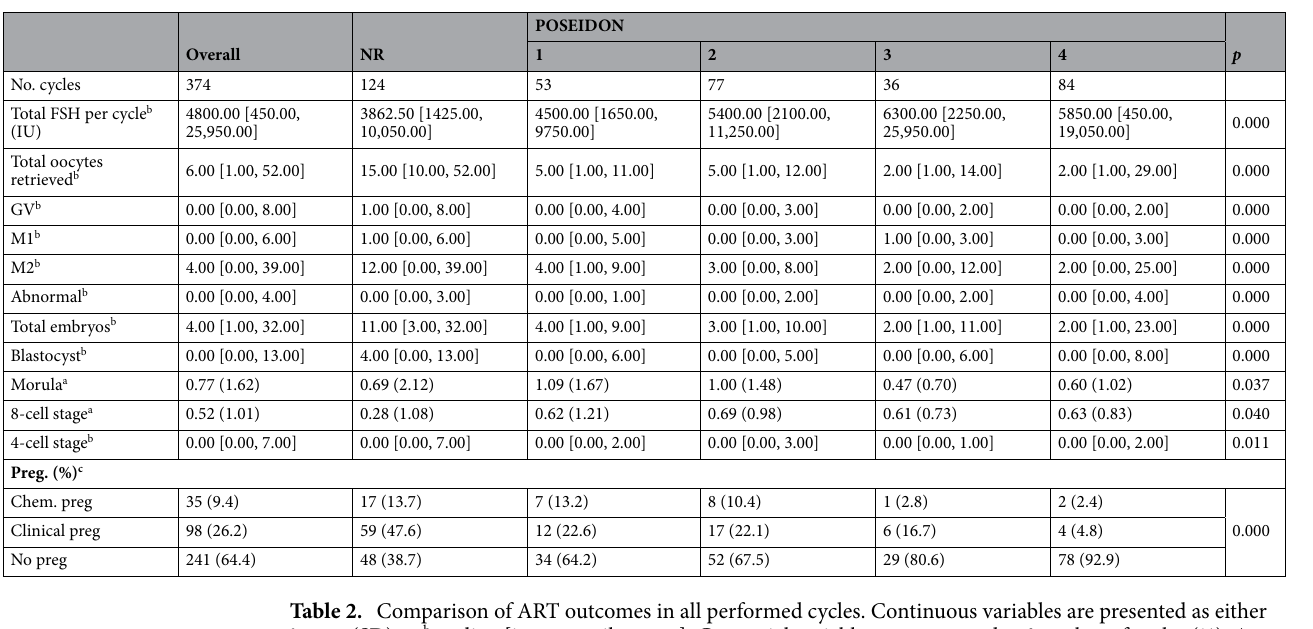
Table 2. Comparison of ART outcomes in all performed cycles. Continuous variables are presented as either a mean (SD) or b median [interquartile range]. Categorial variables are presented as c number of cycles (%). A p-value < 0.05 was considered statistically significant. NR normal responder, No. number, GV germinal vesicle, M1 metaphase I, M2 metaphase II, Preg. Pregnancy, Chem. Chemical, POSEIDON patient-oriented strategies encompassing individualized oocyte number.